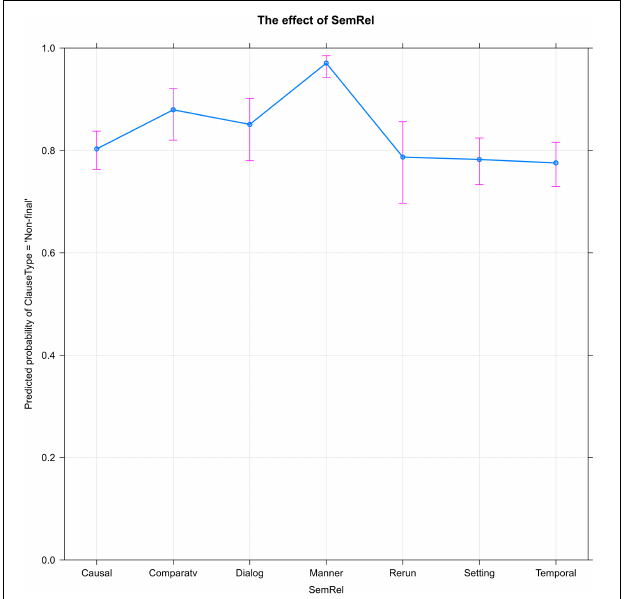
FIGURE 2 | Of the seven semantic relations coded, Manner strongly increases the probability of clause linking (ClauseType = ‘Non-final’).